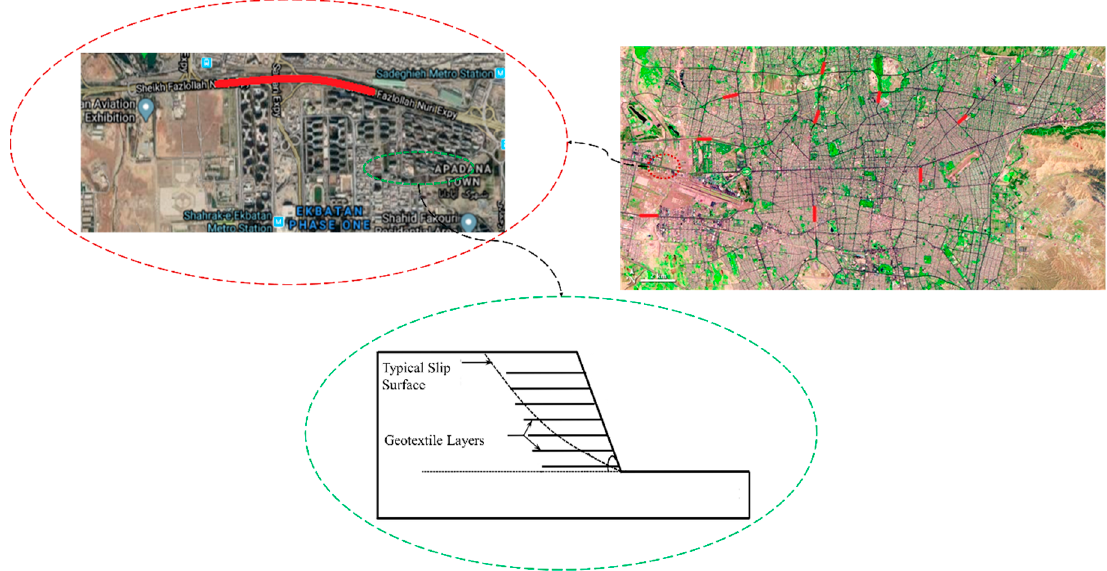
Figure 3. Graphical representation of the location of the case study.